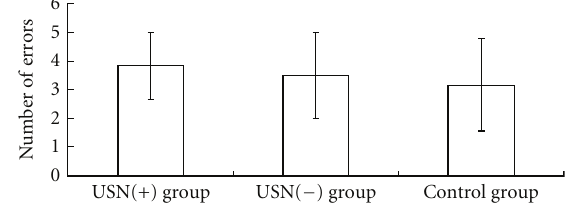
Figure 2: Comparison of the number of errors in the prism adaptation task. There was no significant di ff erence between the 3 groups ( P = 0 . 72). USN: unilateral spatial